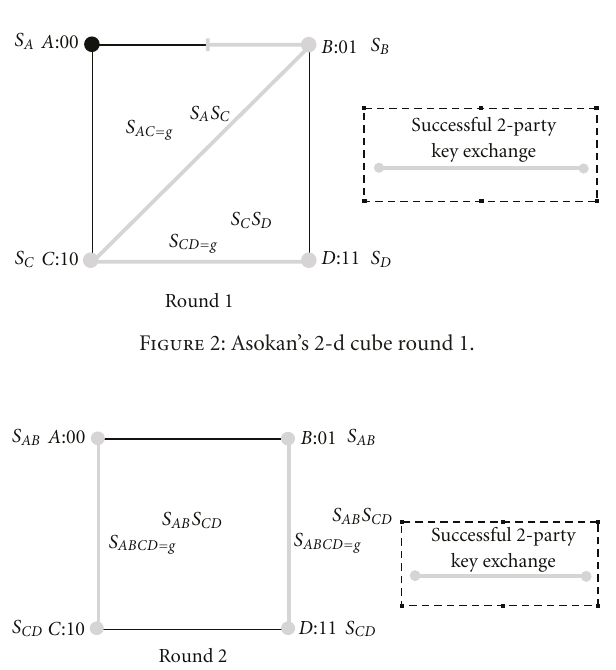
Di ffi e-Hellman protocol for pairwise exchanges in each round of the d -cube